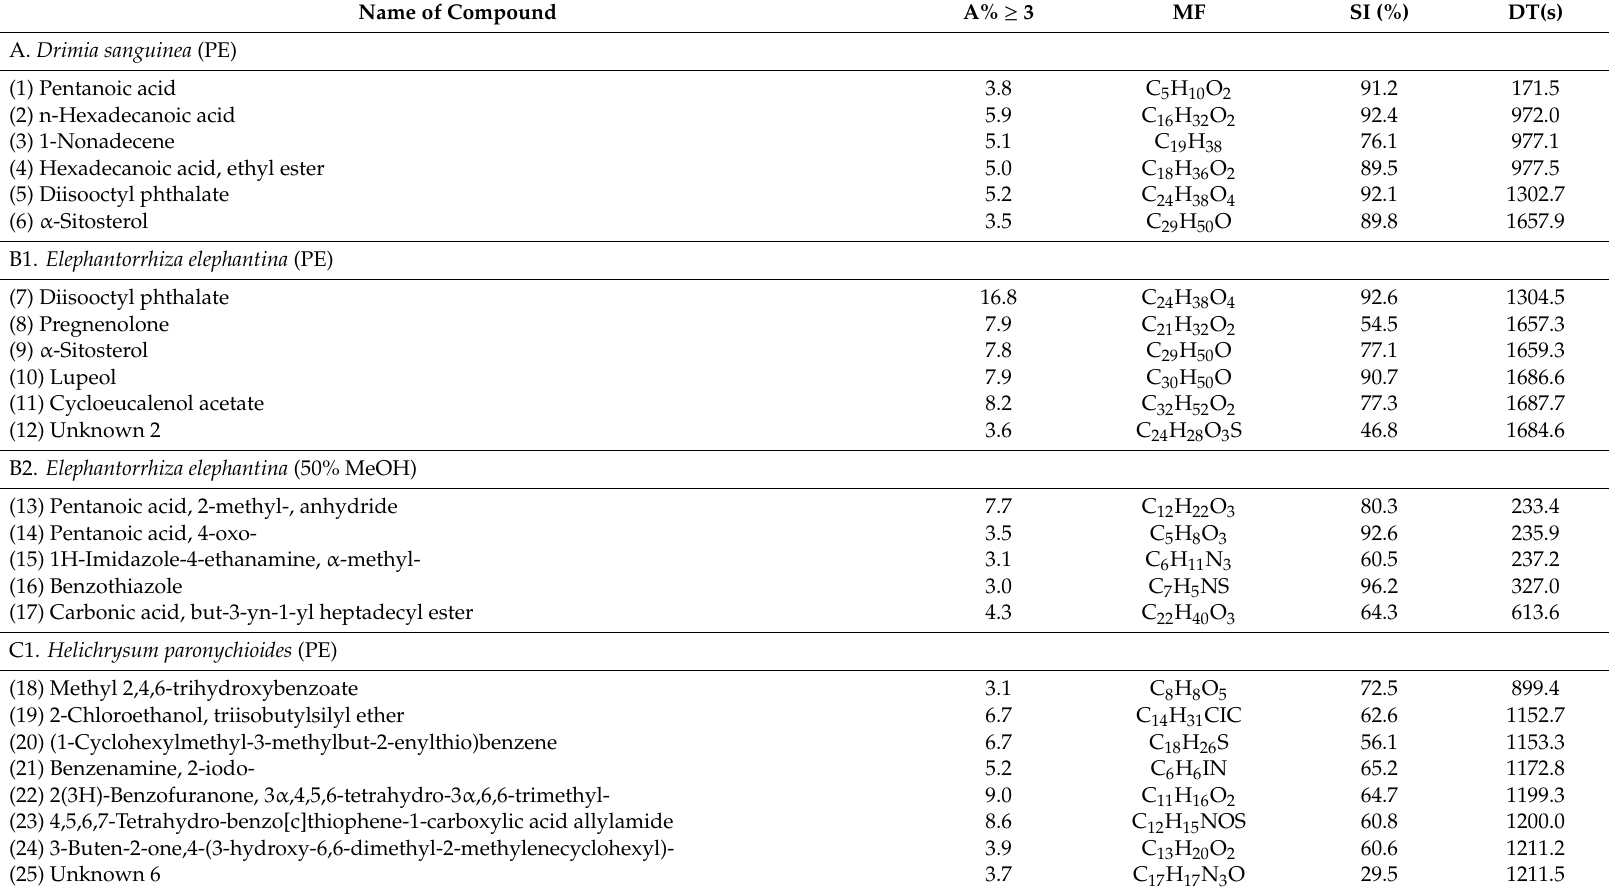
Table 5. Compounds detected by Gas chromatography–mass spectrometry (GC-MS) analysis with peak area greater than 3% from polar and non-polar extracts of the four plants used by the Batswana traditional health practitioners to treat skin diseases. A% = Area percentage, MF = Molecular formula, SI = Similarity index and DT = Detection